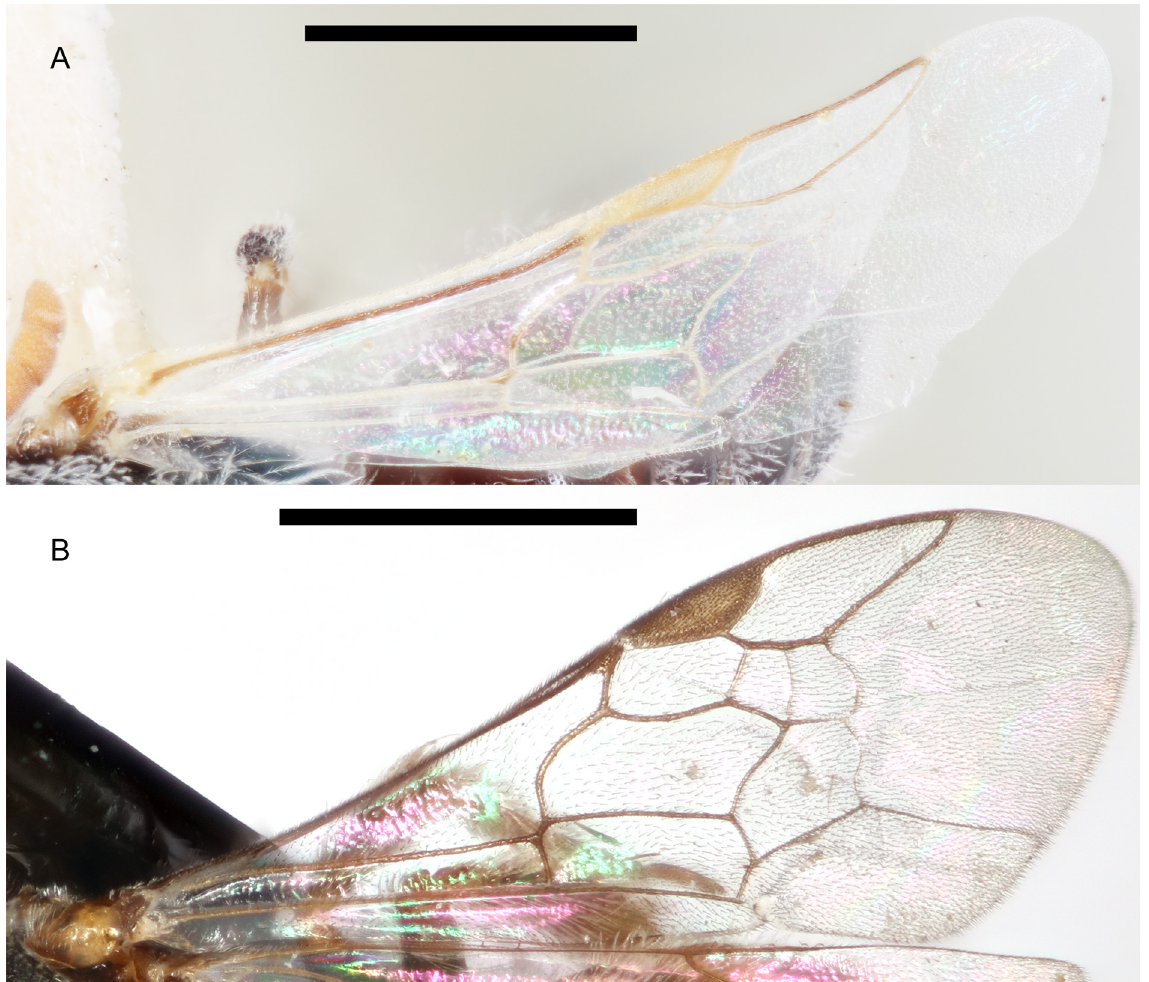
Fig. 100. Forewings. A . Lasioglossum ( D. ) pallidellum (Ellis, 1914), ♂, with white hair, pale veins, and hyaline membrane. B . L. ( D. ) decorum sp. nov., ♀, with dark hair, dark veins, and lightly infuscated membrane. Scale bars: 1